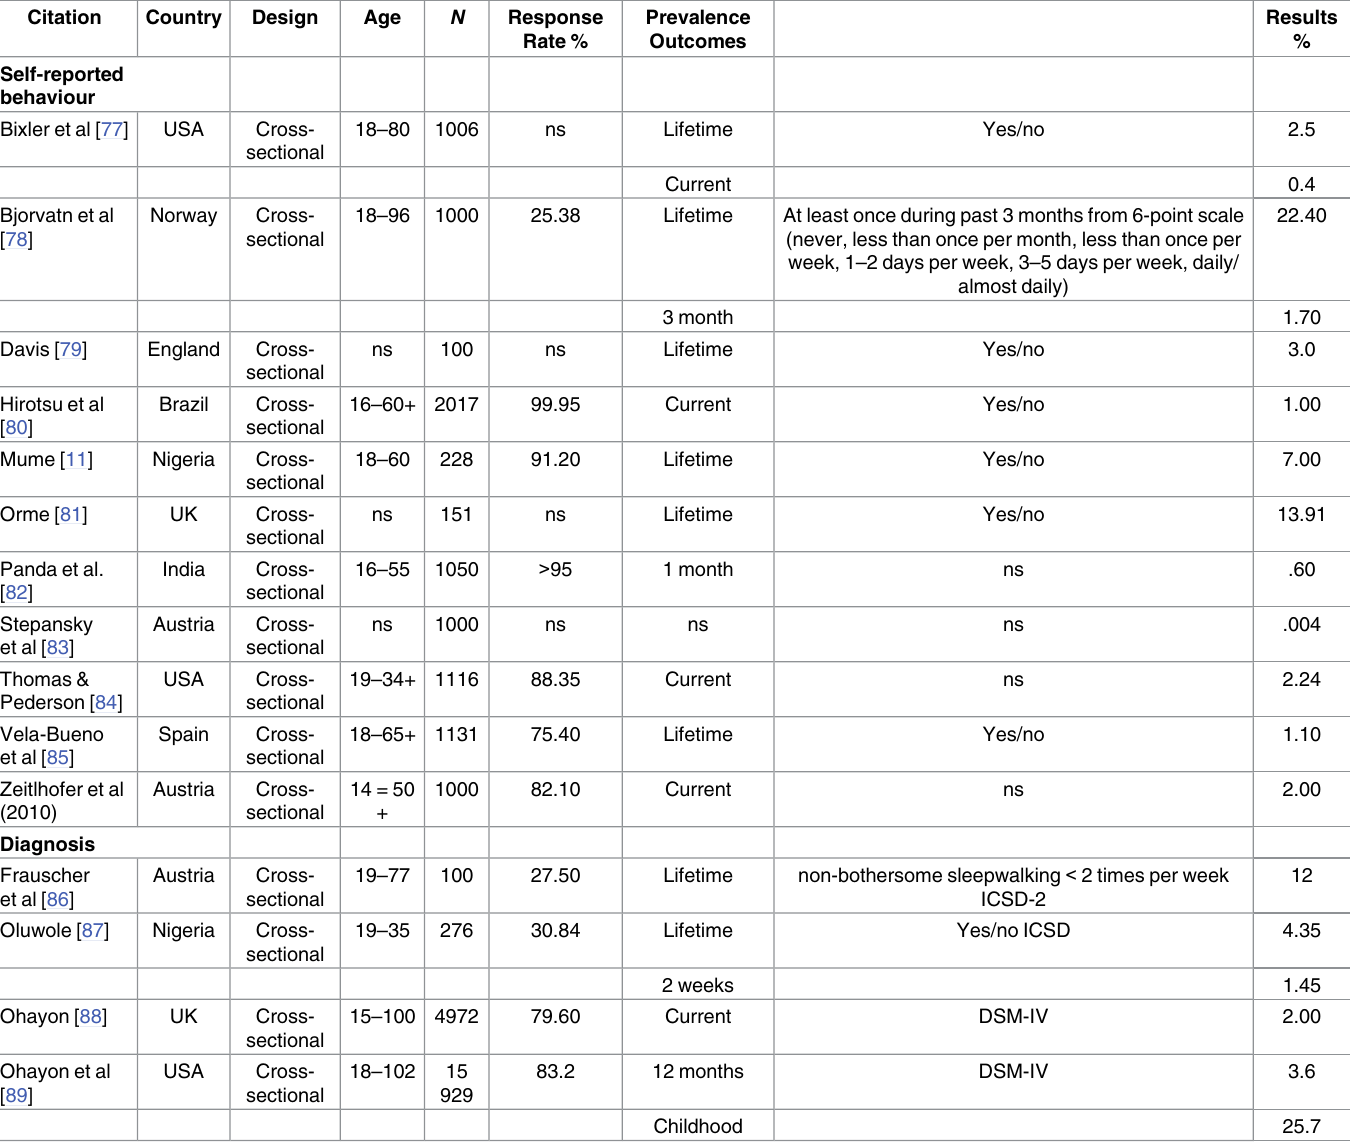
Table 2. Characteristics of Included Studies of Adults listed by Measurement